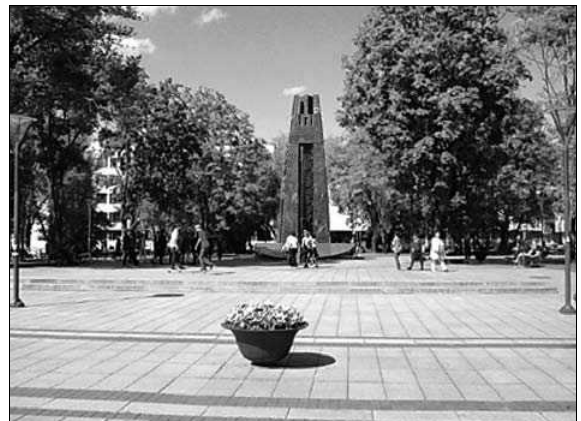
Fig. 3. Doctor V. kudirka Monument (sculpt. a. Sakalauskas, archit. r. krištapavičius)